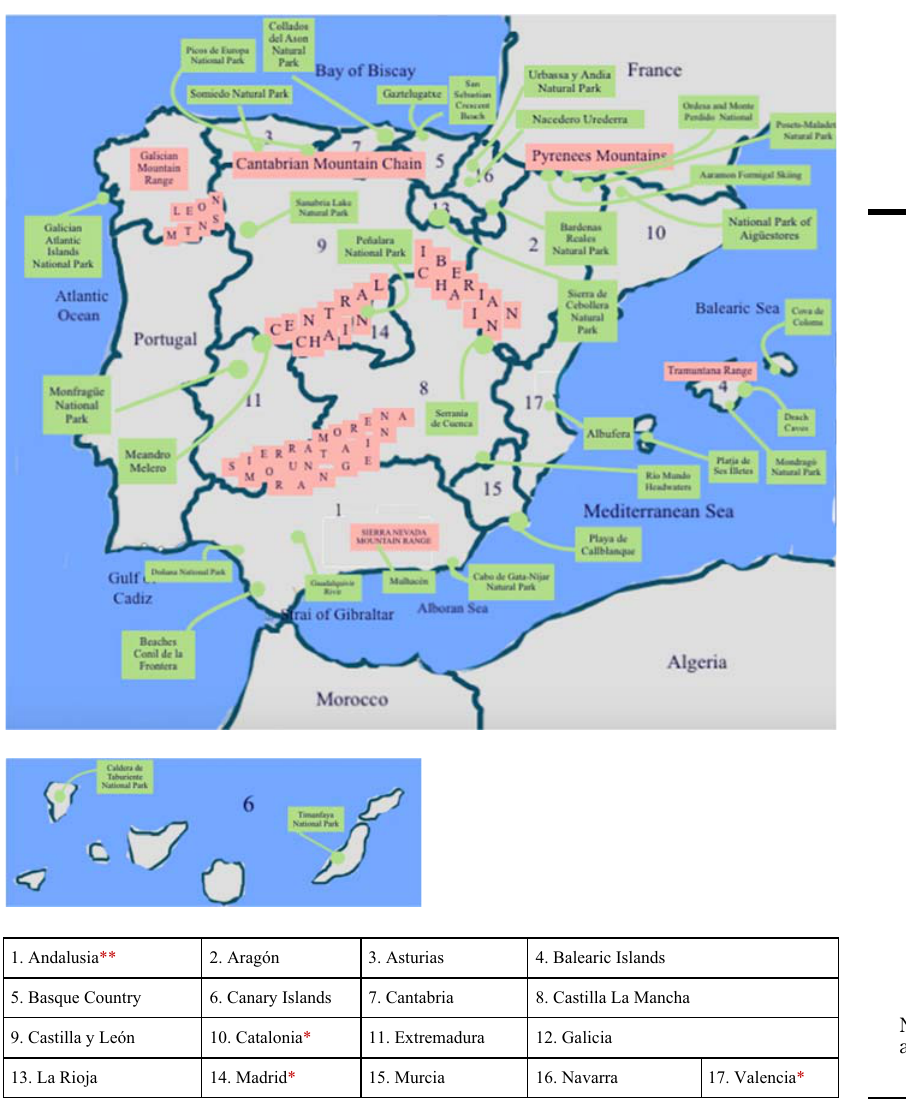
Figure 2. Natural